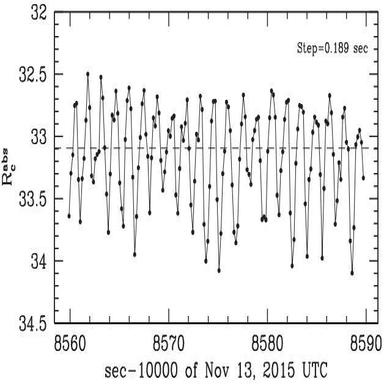
The quick variability of WT1190F clearly appears in this R-band trailing frame from Loiano, taken at 05:09:34 UTC of 2015 November 13 (see). A total of 21 pulses can easily be recognized in the figure, suggestive of a flashing period slightly shorter than 1.5 s. The time span of target trail across the CCD pixels, for this frame, is 0.189 s px1 .